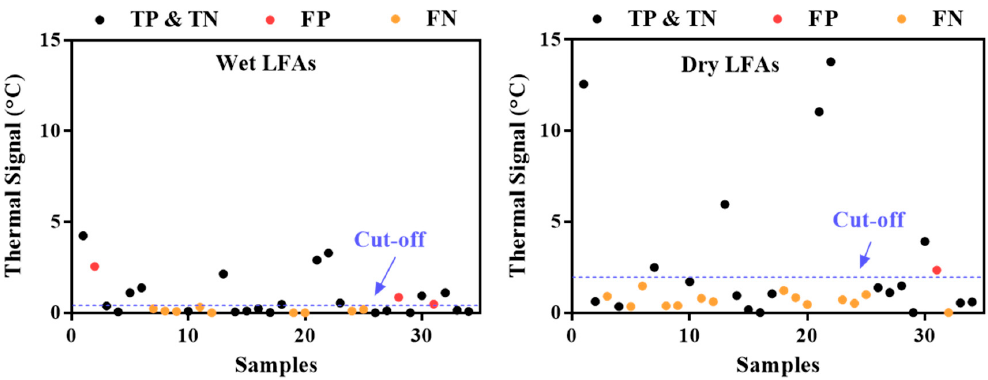
Figure 5. Comparison of thermal signals from wet and dry lateral flow assays (LFAs) from 34 samples. The numbering of the samples is the same in both plots.